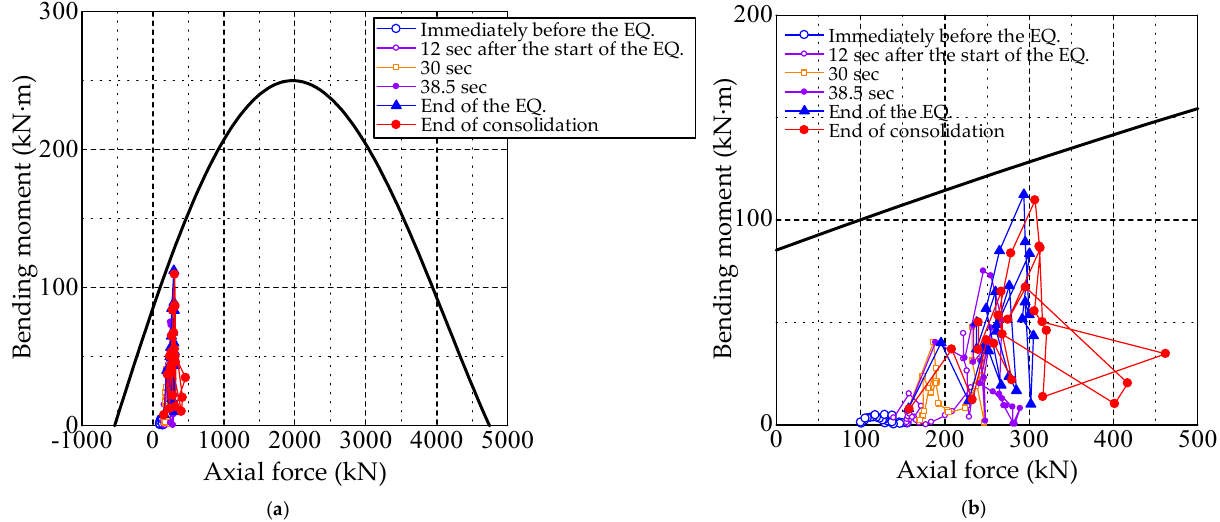
Figure 19. Plot on M–N failure diagram and changes in the bending moment over time, seismic motion (A): ( a ) M–N failure diagram; ( b ) enlarged view of ( a ).